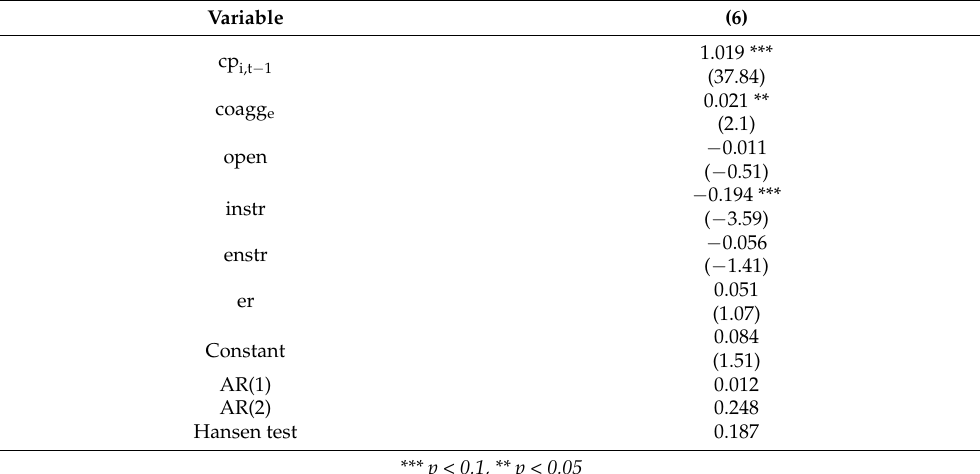
Table 3. Robustness